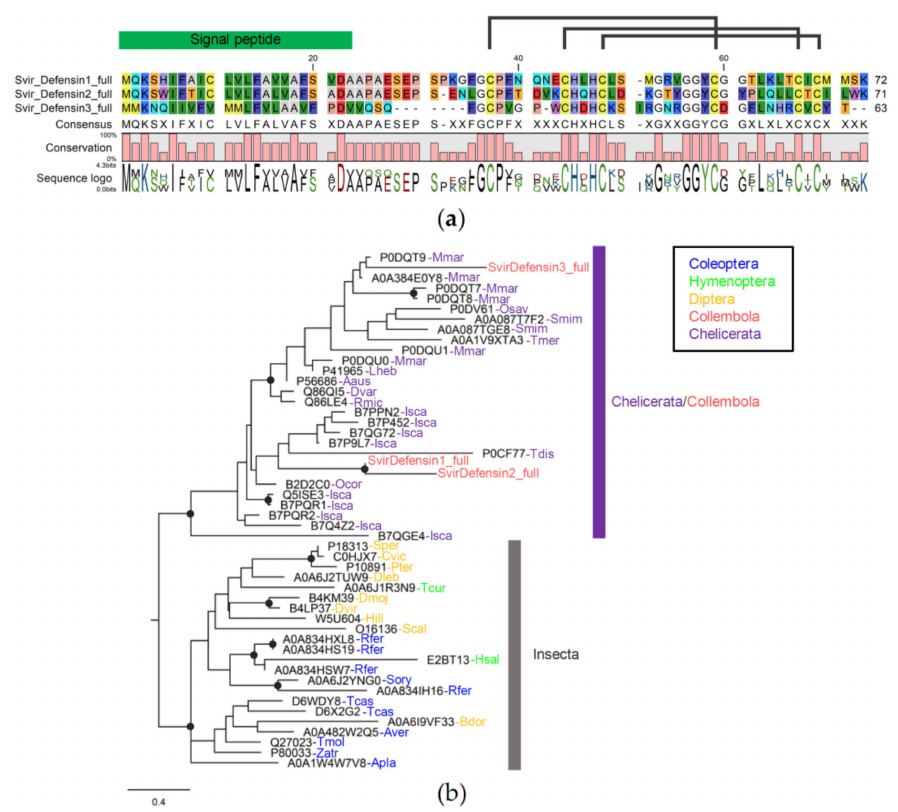
Figure 7. Sequence alignment and phylogenetic relationships of collembola defensin: ( a ) protein alignment showing disulfide bridges between six conserved cysteine residues; ( b ) Phylogenetic tree of arthropod defensins. Branch supports (aLRT) higher than 0.9 were indicated with black dots on tree nodes (Abbreviation: Svir = Sm. viridis , Mmar = Mesobuthus martensii , Osav = Ornithodoros savignyi , Smim = Stegodyphus mimosarum , Tmer = Tropilaelaps mercedesae , Lheb = Leiurus hebraeus , Aaus = Androc- tonus australis , Dvar = Dermacentor variabilis , Rmic = Rhipicephalus microplus , Isca = Ixodes scapularis , Ocor = Ornithodoros coriaceus , Tdis = Tityus discrepans , Sper = Sarcophaga peregrina , Cvic = Calliphora vicina , Pter = Protophormia terraenovae , Tcur = Temnothorax curvispinosus , Dleb = Drosophila lebanonensis , Dmoj = D. mojavensis , Dvir = D. virilis , Hill = Hermetia illucens , Scal = Stomoxys calcitrans , Rfer = Rhyn- chophorus ferrugineus , Hsal = Harpegnathos saltator , Sory = Sitophilus oryzae , Tcas = Tribolium castaneum , Bdor = Bactrocera dorsalis , Aver = Asbolus verrucosus , Tmol = Tenebrio molitor , Zatr = Zophobas atratus , Apla = Agrilus planipennis